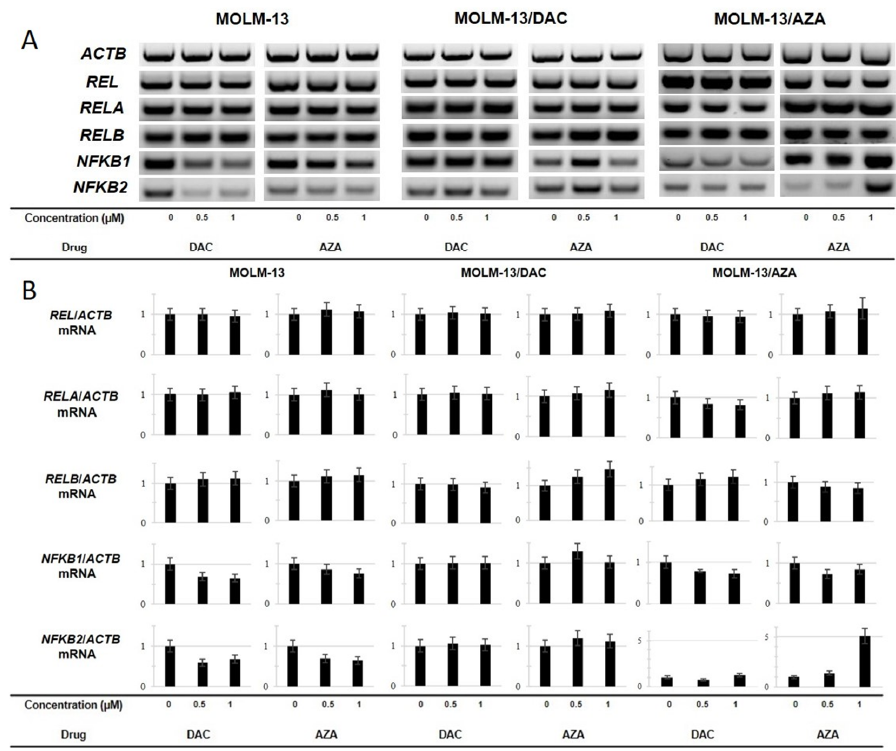
Figure 8. ( A ): Changes in the relative expression of the REL , RELA , RELB , NFKB1 and NFKB2 genes in sensitive and resistant cell lines as determined by RT-PCR. The cells were incubated for 72 h in growth medium in the absence or presence of AZA or DAC in a CO 2 incubator. The data for 24 and 48 h of incubation are shown in the Supplementary files (Figures S6 and S7 in the Supplementary data). The cells were treated every 24 h with AZA or DAC. ACTB was used as an internal control. ( B ): The optical densities of the PCR product bands were quantified and are summarized in bar plots. The data are expressed as the mean ± SD of three independent measurements.